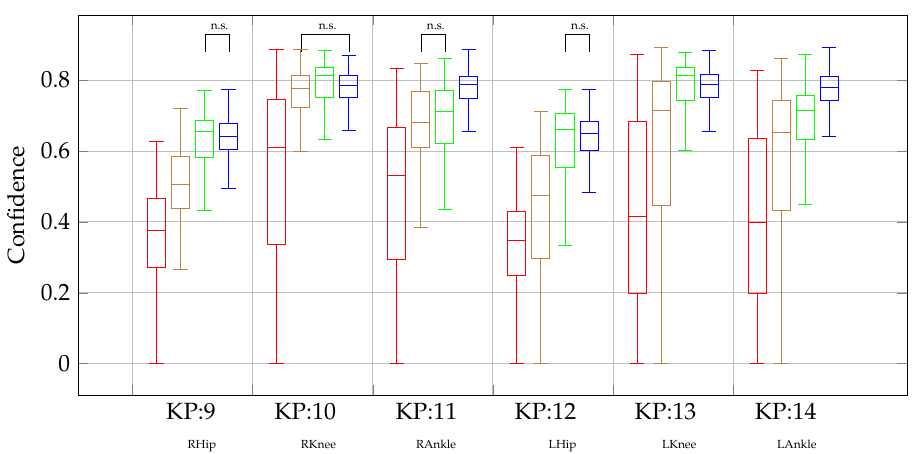
Figure 7. Confidence of detection of selected KP (keypoints)—¾ view, lower body. Camera views are shown in colour as follows: lying down ( N = 177); on the knees ( N = 95); sitting ( N = 165); and standing ( N = 490). All the other differences are statistically significant. Only differences that were not statistically significant (n.s.) are highlighted in the boxplots.